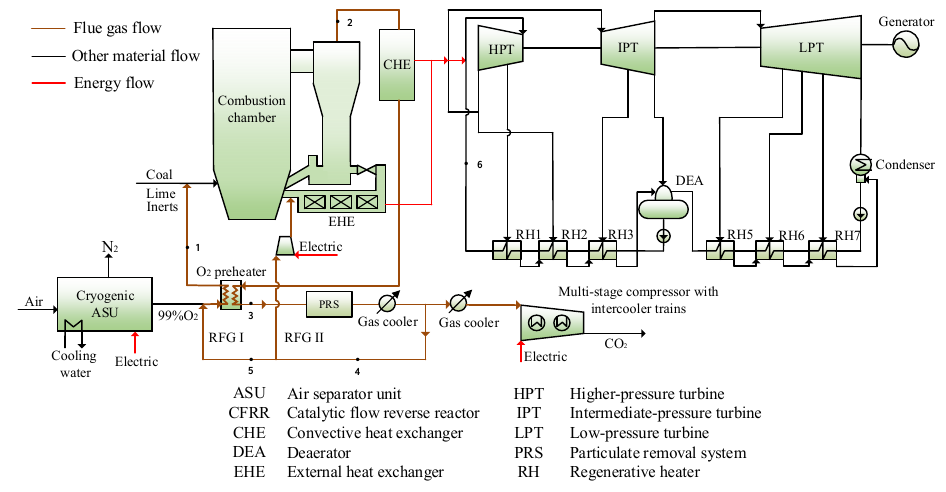
Figure 2. Schematic of the reference system I.